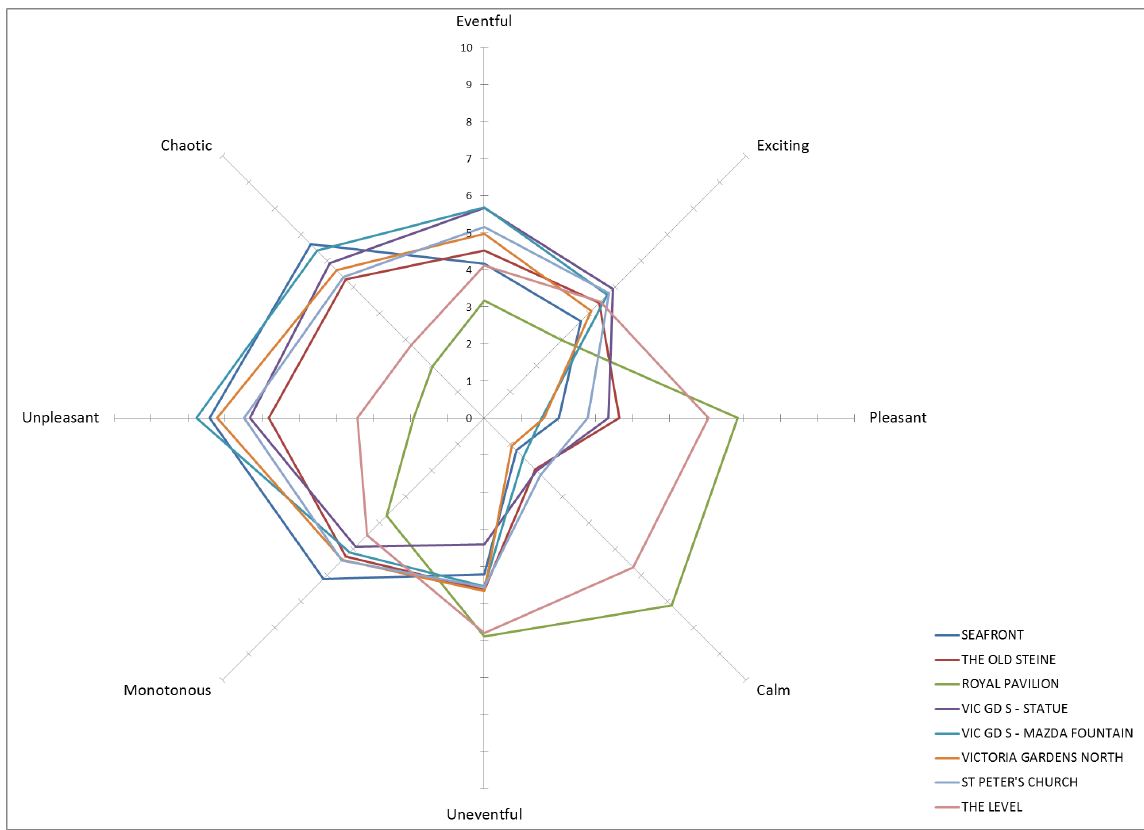
Figure 5: Mean values of the individual responses for Q2, represented according to Ref. [59]